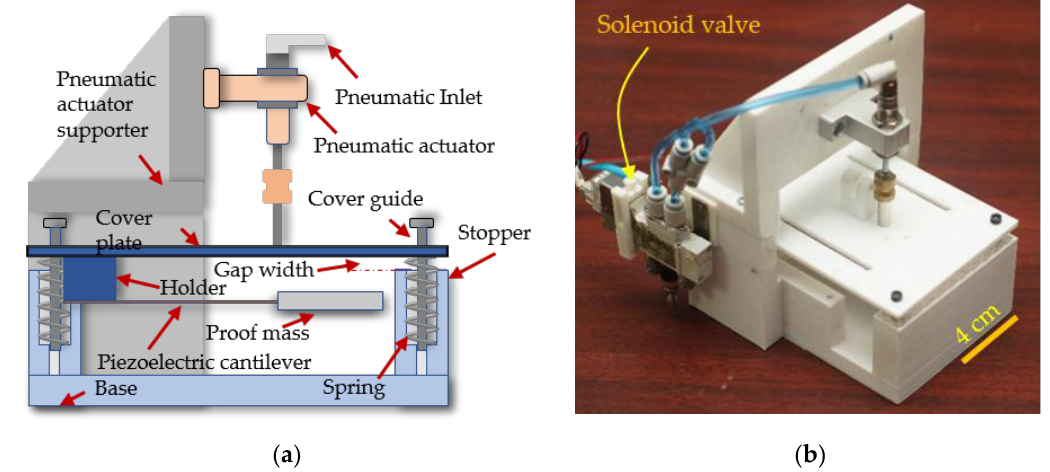
Figure 1. Piezoelectric energy harvester (PEH) test bench: ( a ) cross-section of PEH; ( b ) photograph of PEH test bench.